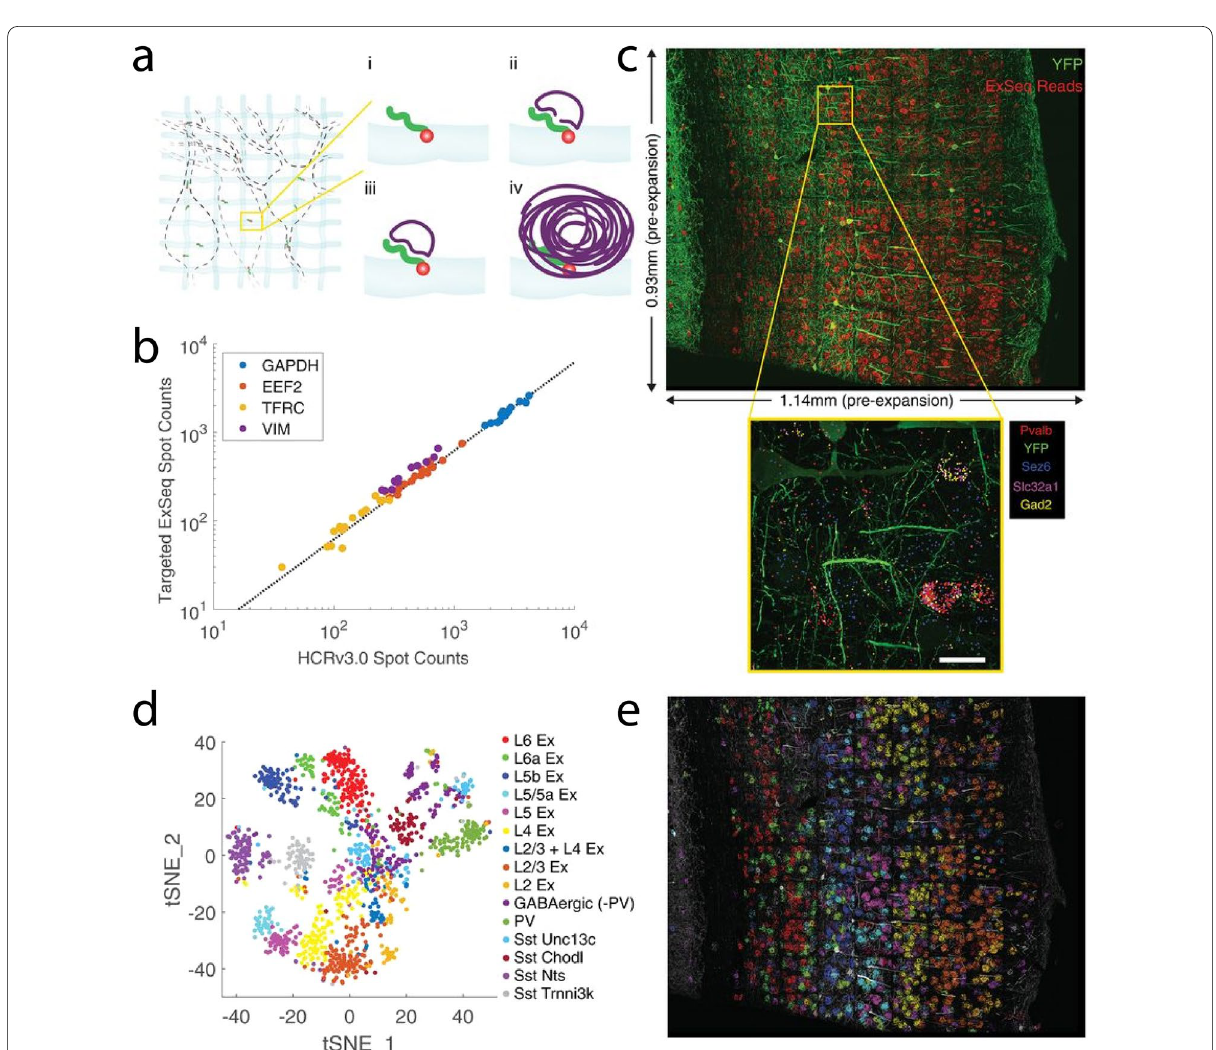
Fig. 9 Spatial mapping of RNAs using Expansion Sequencing (ExSeq). a Targeted ExSeq library preparation: (i) RNA anchoring and expansion, (ii) padlock probe hybridization, (iii) probe ligation, and (iv) rolling circle amplification. b Amplicon counts for targeted ExSeq versus HCRv3.0-amplified ExFISH for the same transcript in the same HeLa cell (60 cells). c Targeted ExSeq of 42 cell type marker genes in Thy1-YFP mouse visual cortex. (Top) Fluorescence image showing targeted ExSeq reads (red) and YFP (green). (Bottom) Localization of marker genes Pvalb (red), Sez6 (cyan), Slc32a1 (magenta), and Gad2 (yellow) with YFP (green). Scale bar, 20 μm. d Targeted ExSeq gene expression profiles of 1154 cells clustered into 15 cell types. e Spatial organization of cell types identified in d . Cell-segmented reads are shown, colored by cluster assignment, and overlaid on YFP (white). (From Alon et al. [61]. Reprinted/adapted by permission from